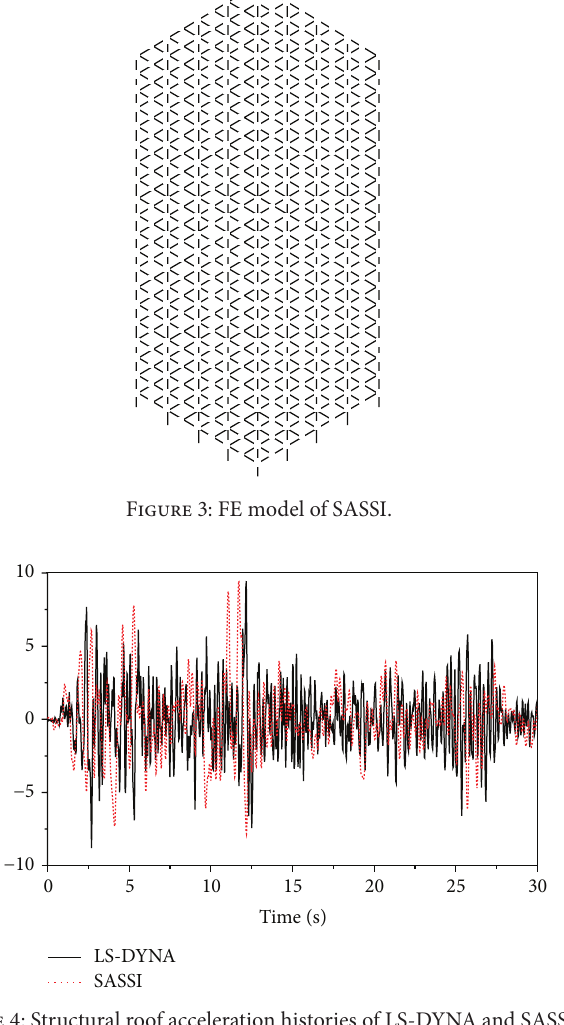
Figure 4: Structural roof acceleration histories of LS-DYNA and